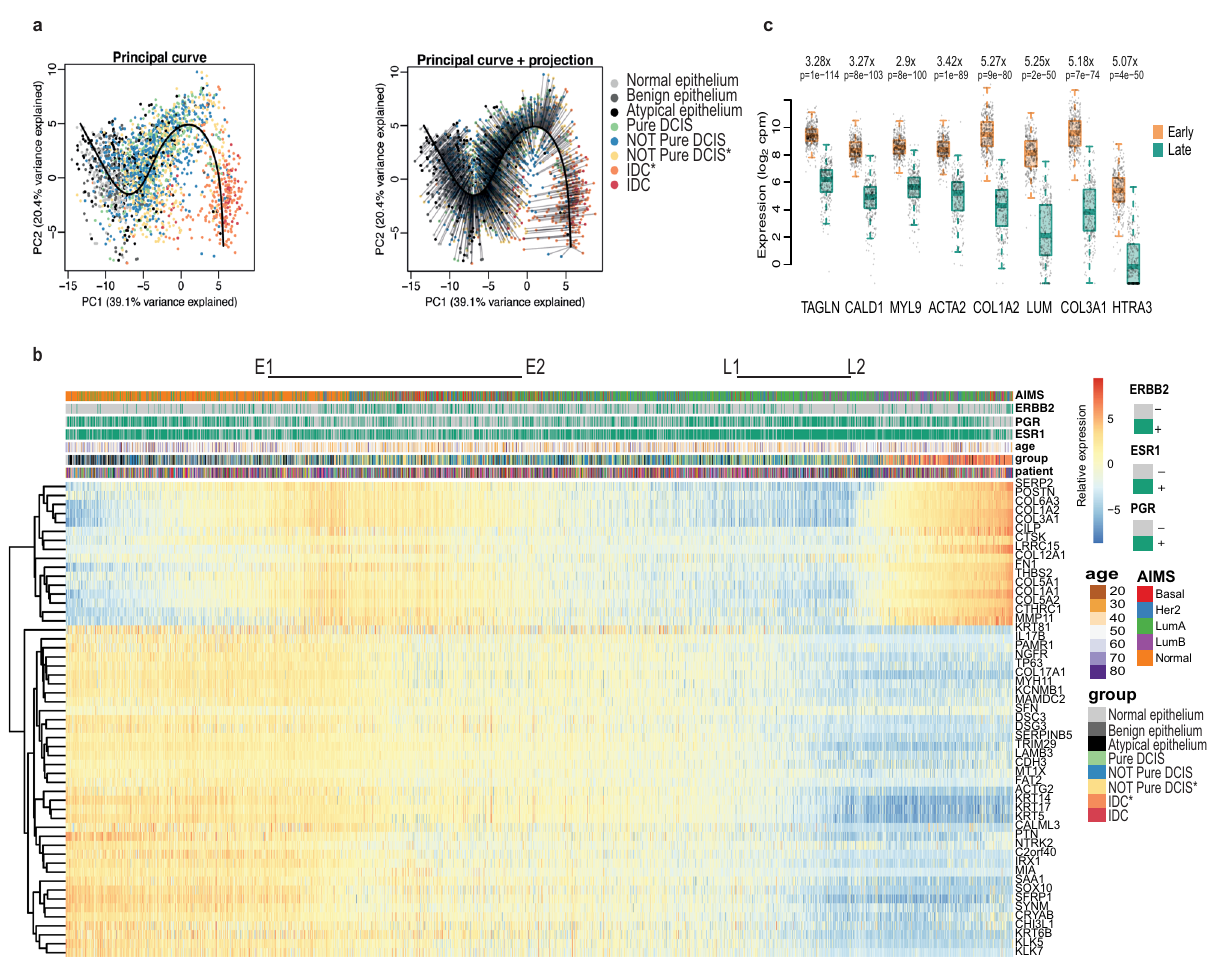
Fig. 3 Generating a pseudo-time for DCIS. a Principal component analysis (PCA) plot based on the most signi fi cant (p < 0.00001) differentially expressed genes between DCIS and co-occurring IDC. All samples plotted according to principal components 1 and 2 (PC1 and PC2 respectively) with their fi tted principal curve (left), and with their projection onto the curve (right). b Heatmap showing expression of each of the 53 genes with samples ordered by their projection to the principal curve. Top bars indicate AIMS subtype classi fi cation, ERBB2 , PGR , and ESR1 status, age of patient at the time of consent, tissue classi fi cation group for each sample, and patient distribution. Relative expression is provided as log 2 counts per million (CPM) minus the mean log 2 CPM for each gene. E1 – E2 indicate the Early stage and L1 – L2 indicates the Late stage. The ‘ * ’ assigned for ‘ Yellow Not Pure DCIS ’ and ‘ Orange IDC ’ indicates samples used in the analysis comparing gene expression of DCIS vs IDC for co-occurring patients. ‘ Blue Not Pure DCIS ’ and ‘ Red IDC ’ are from tissue biopsies that did not have co-occurring DCIS and IDC in the same sections and were therefore not used for this expression analysis. ( c ) Boxplots illustrating per sample expression data for highly differential genes found when comparing samples in the Early group (E1-E2) with those in the Late group (L1 – L2). Differential expression analysis was done using limma-voom and two-sided p-values were adjusted for multiple testing using Benjamini-Hochberg correction. Centre line represents the median, box limits represent upper and lower quartiles, whiskers represent minimum and maximum values and at most 1.5x the interquartile range. Each point represents a sample, n = 339 early and n = 287 late samples from 106